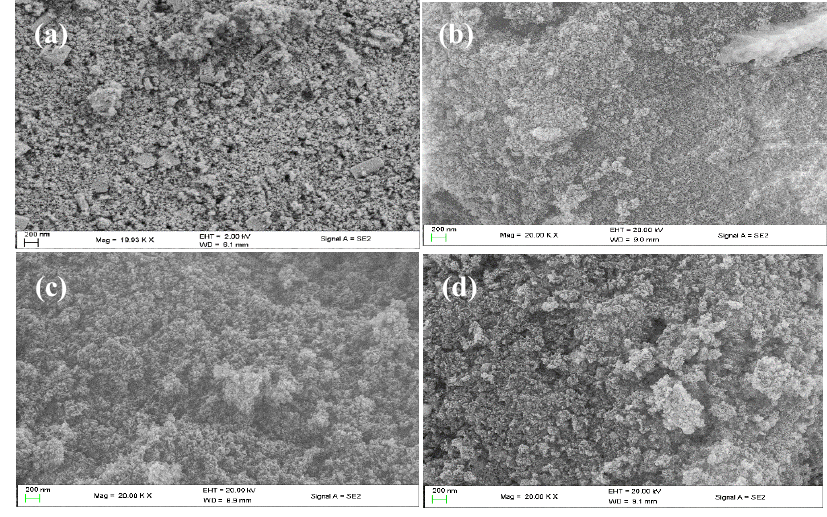
Figure 3. SEM images of ( a ) γ-Al 2 O 3 , ( b ) 2.5% Mn/γ-Al 2 O 3 , ( c ) 5% Mn/γ-Al 2 O 3 , ( d ) 7.5% Mn/γ-Al 2 O 3 catalysts.